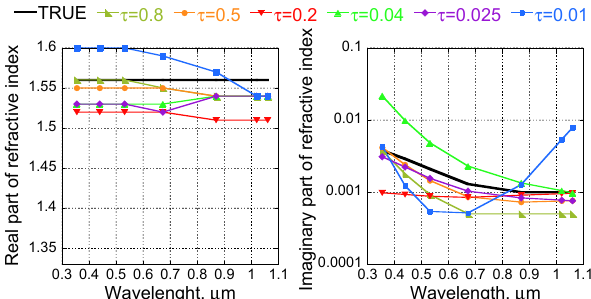
Fig. 5. Retrievals of complex refractive index of the “Dust” aerosol model under different